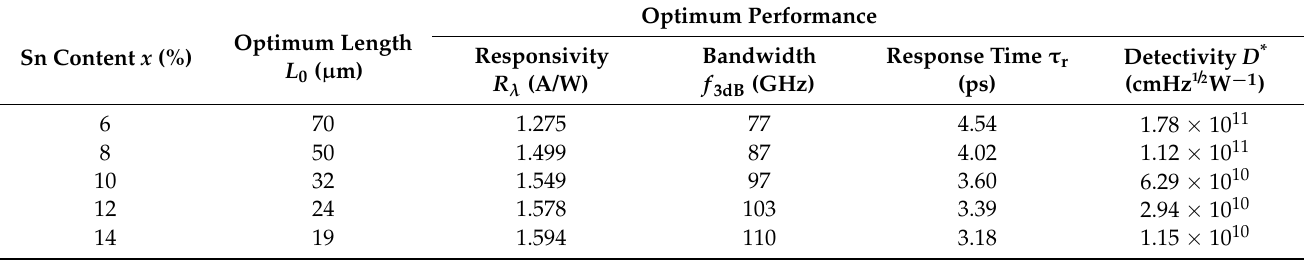
Table 1. Comparative study of the optimally designed GeSn WGPD for different Sn concentration at 2 µ m wavelength.